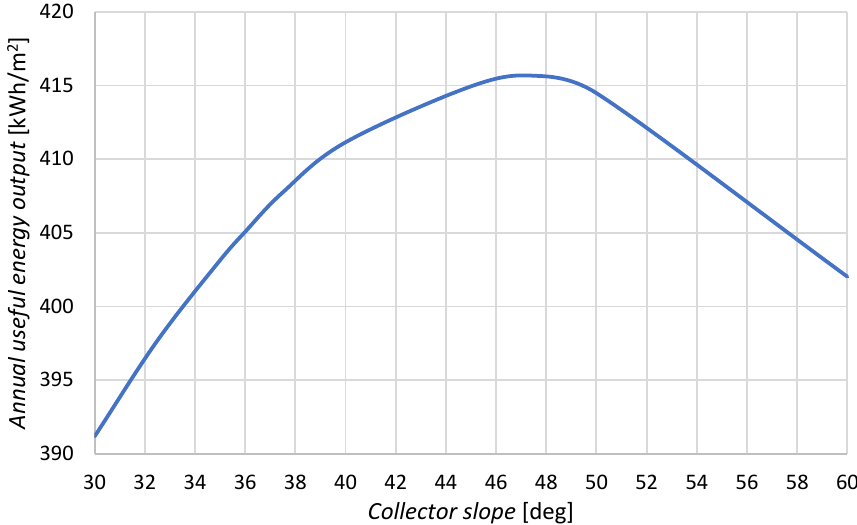
Figure 9. Dependence of the inclination angle of the solar collector on an annual useful energy output for Helsinki.